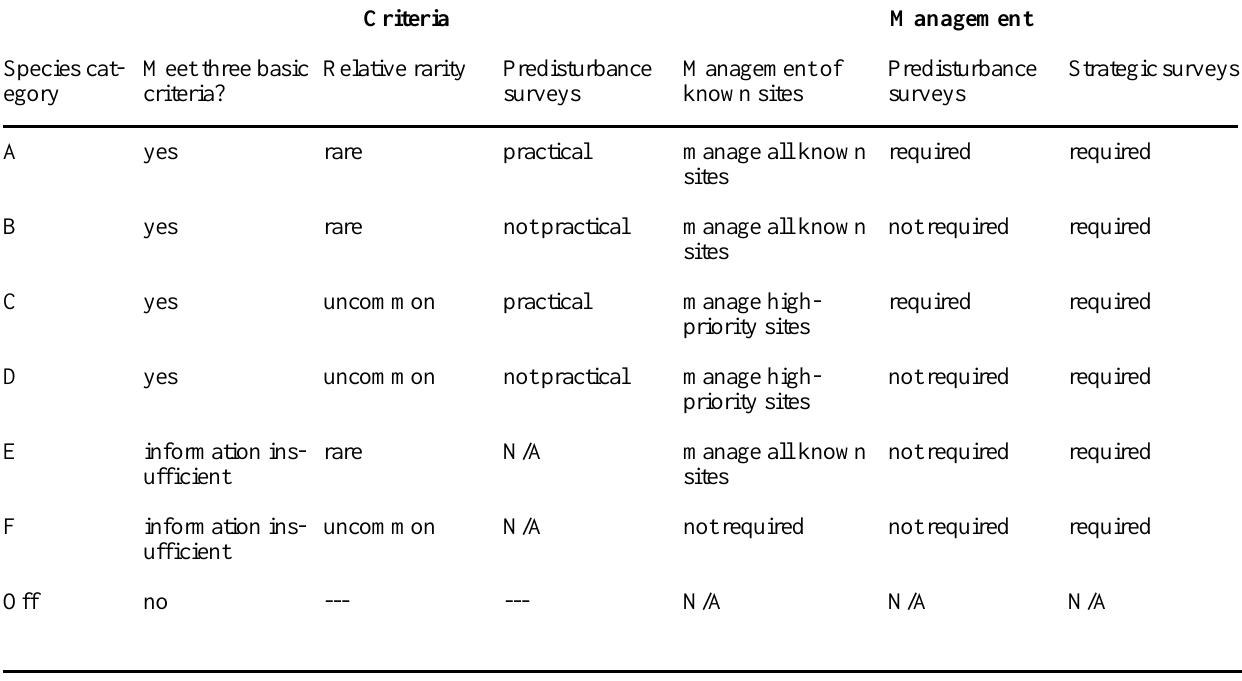
Table 1. Criteria and management of conservation categories of Survey and Manage species (USDA and USDI 2001). N/A = not applicable. The “three basic criteria” refer to occurrence in the Northwest Forest Plan area, association with late-successional and old-growth forests, and plan provision for persistence. “Off” means not to be included under the Survey and Manage species mitigation. Also see Table 2 for further